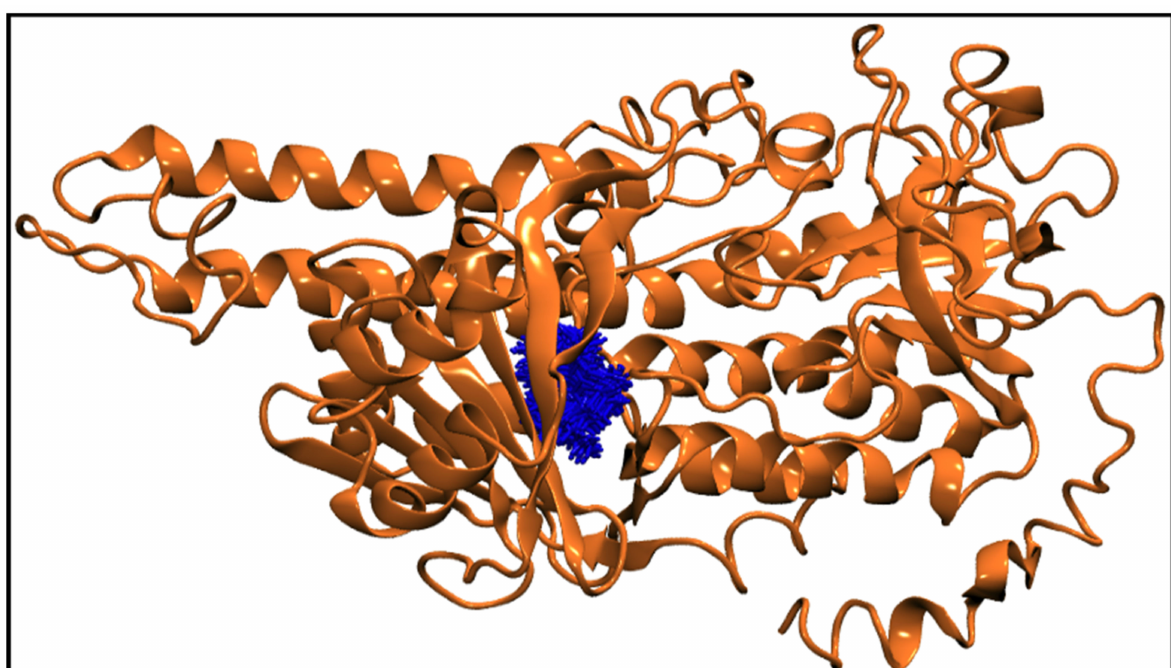
Figure 9. 100 Snapshots of TQ (blue licorice representation) taken at every 1 ns from a 100 ns long trajectory showing the spatial distribution of the ligand in the protein binding site. The squalene monooxygenase protein (cartoon representation) is shown at 0 ns, representing the initial conforma- tion of the